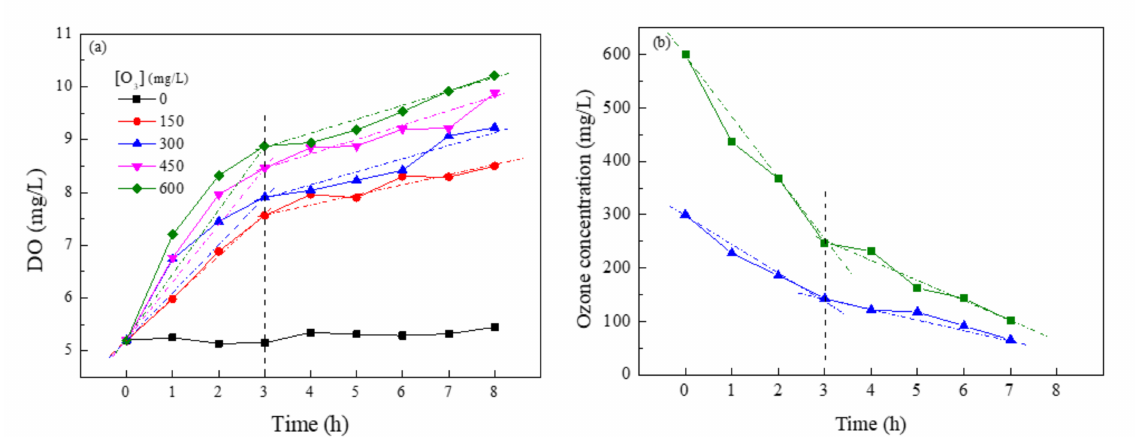
Figure 10. ( a ) Effect of ozone concentration in ice on the DO in the leaching solution. ( b ) Retention of ozone in the